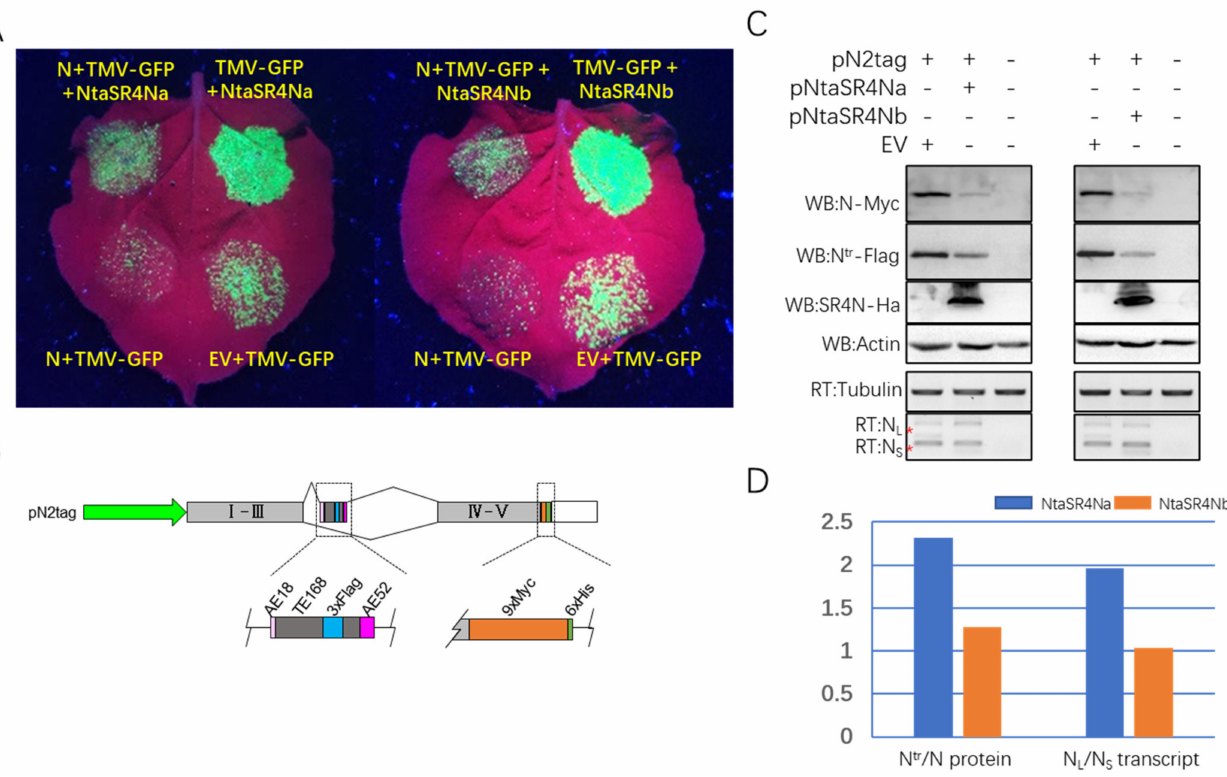
Figure 4. NtaSR4N promotes TMV replication but reduces N protein accumulation. ( A ) Green florescence imaging of agrobacteria-infiltrated N. benthamiana leaves under UV light. White circles mark the infiltrated patches with co-expressed genes indicated next to each circle. ( B ) Structure of N gene in pN2tag construct. Green arrow represents the native N promoter. Gray boxes marked I–III and IV–V represent fused exons I–III and exons IV–V of the wild-type N gene. The dashed box marks the modified alternative exon and 3 (cid:48) ORF: AE18 and AE52 represent the 5 (cid:48) 18- and 3 (cid:48) 52-bp sequences of the 70-bp AE of wild = type N ; TE168 represents a 168-bp SINE element from the tobacco genome (Supplementary Data S1); 3 × FLAG, 9 × Myc, and 6 × His represent three-times Flag, nine-times Myc, and six = times His epitope tags, respectively. The open box represents the 3 (cid:48) GRS of N . ( C ) Western blot and RT-PCR analysis of products from N and other genes in co-infiltration experiments. Constructs used in each sample are indicated on top of each lane. Target proteins are indicated to the left of the Western blots (top four panels). Target genes for RT-PCR analysis are indicated to the left of each gel image (bottom two panels). The two red * mark the position of N L and N S transcripts, respectively. ( D ) Quantification of N tr /N ratio at the protein level (left) and N L /N S ratio at the transcript level (right). Blue columns represent data from NtaSR4Na-infiltrated samples, and brown columns represent data from NtaSR4Nb-infiltrated